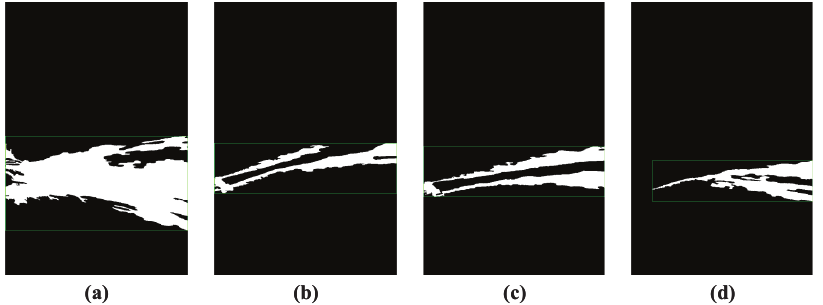
Figure 4. Misdetected results of jet trajectory. ( a ) over detection trajectory result; ( b ) weak detection trajectory result 1; ( c ) weak detection trajectory result 2; ( d ) weak detection trajectory result